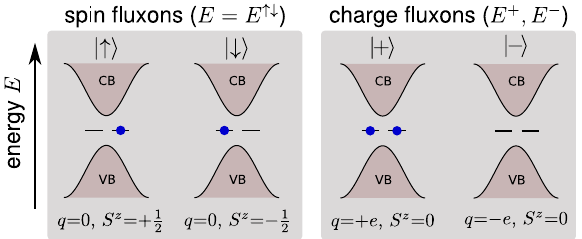
FIG. 2. In a quantum spin Hall insulator, a (cid:1) flux gives rise to four states (with charge q and spin S z ) localized near the flux, which lie inside the bulk energy gap between the valence and conduction bands (labeled ‘‘VB’’ and ‘‘CB’’ in the figure, respectively) [12,31]. The states correspond to a Kramers dou- blet of spin fluxons j "i , j #i with energy E "# and a doublet of charge fluxons jþi , j(cid:2)i with energies E þ , E (cid:2)